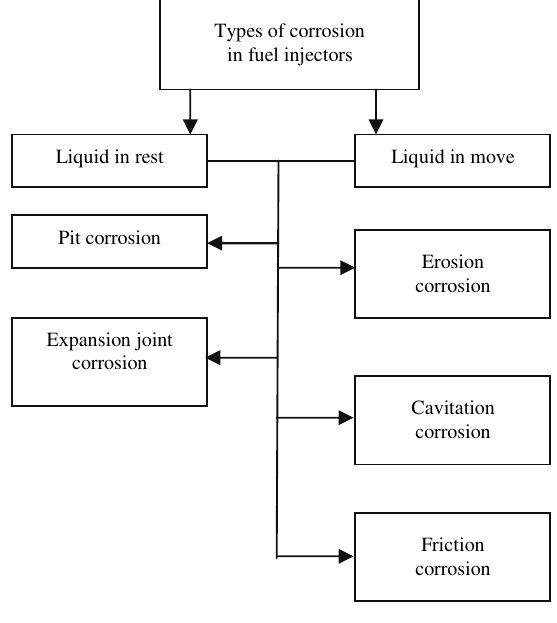
Fig. 1. Types of corrosion in fuel